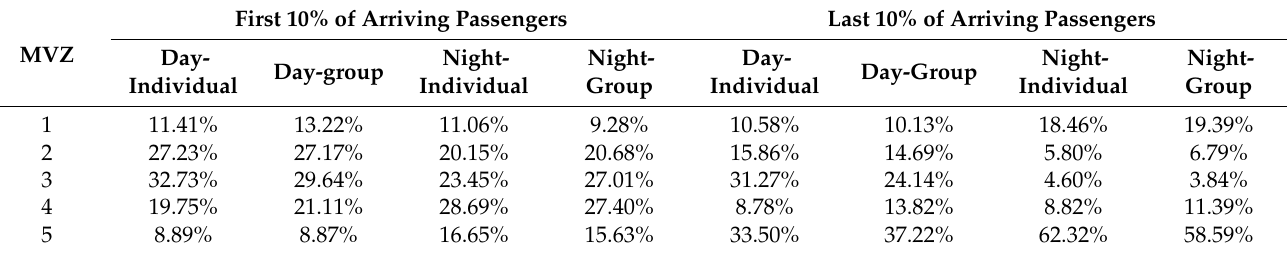
Table 5. Proportions of passengers in different